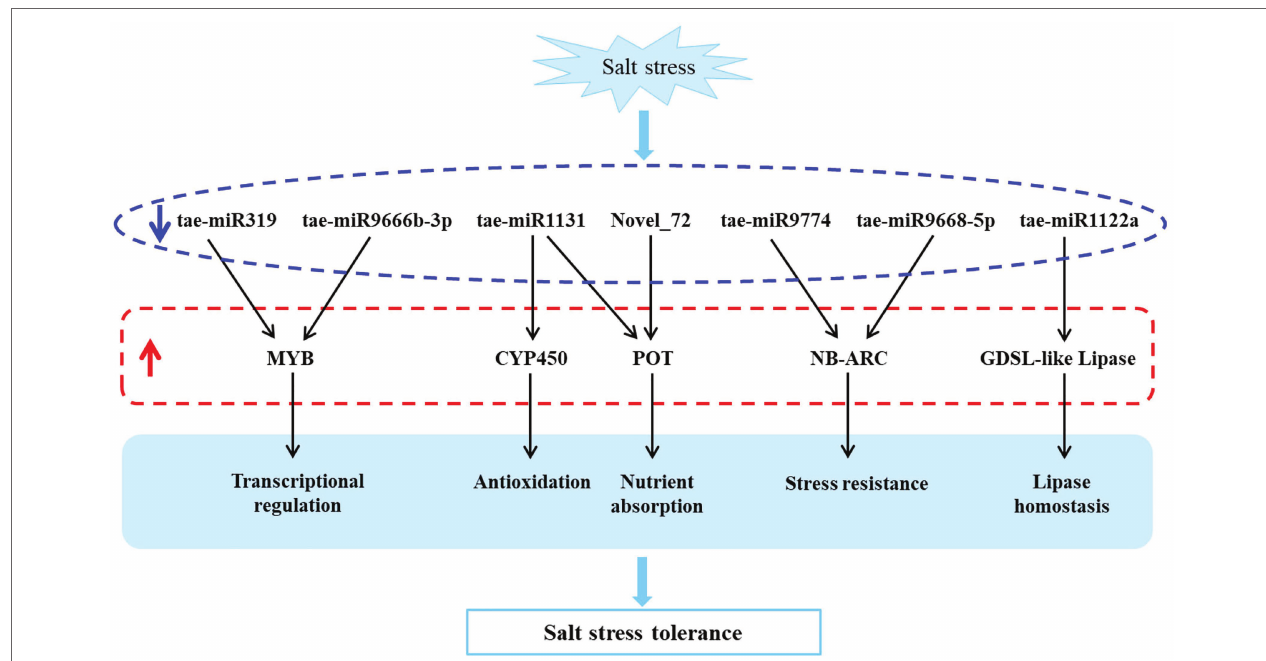
FIGURE 5 | A predicted salt tolerant model of QM6 based on the differentially expressed miRNAs and their target genes. The blue arrow represents down- regulation and the red arrow represents